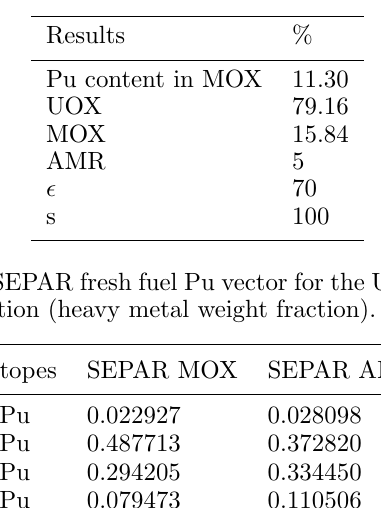
Table 8. UOX - MOX - AMR fleet equilibrium main characteristics.